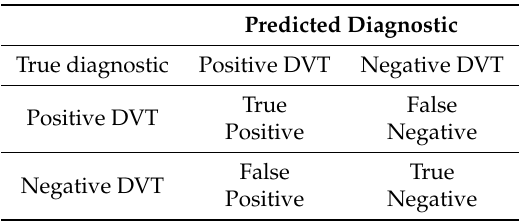
Table 6. Confusion matrix of two-class classification